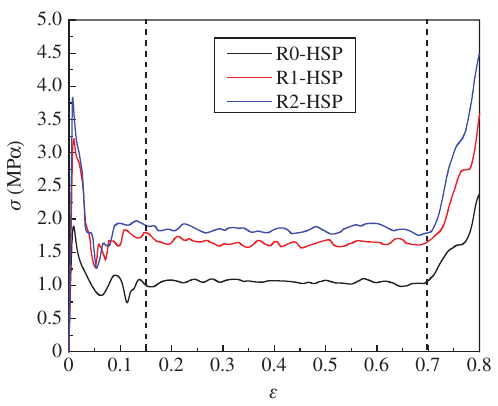
Figure 4: Stress-strain response curves of HSPs at 10 m/s.